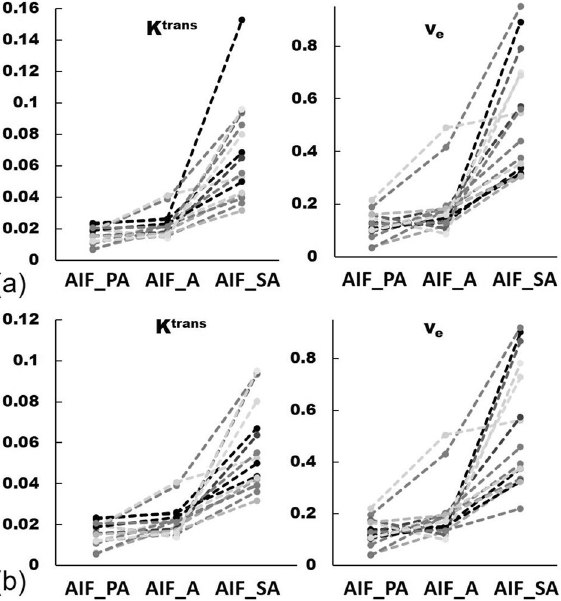
Figure 9. Values for K trans and v e calculated using the population-based (Parker) arterial input function (AIF), aortic AIF, and segmental arterial AIF in 16 vertebrae using a pixel-by-pixel method ( a ) and a region-of-interest method ( b